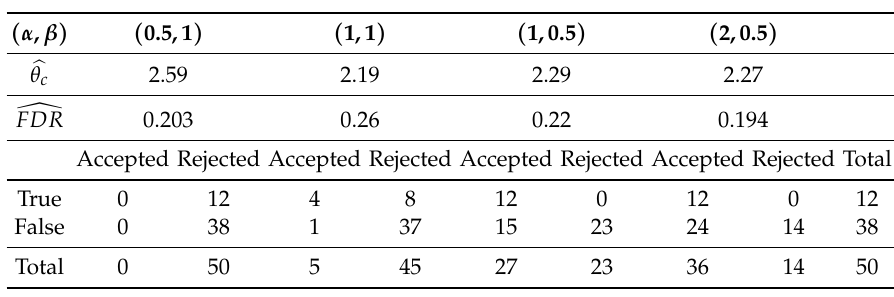
Table 6. Results for the model with Clayton copulas and for data corresponding to 20% of true null hypotheses to distinct values of the prior distributions of p i